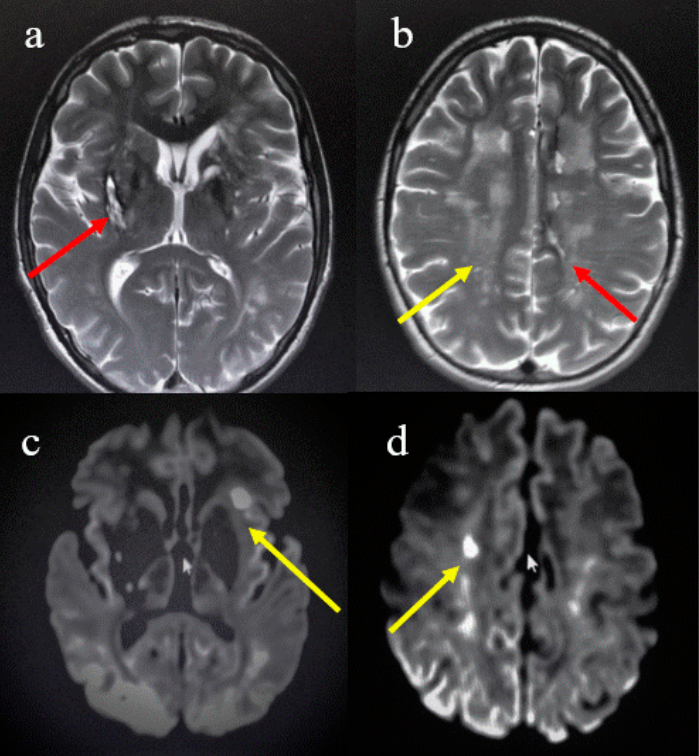
Figure 1. First brain MRI (3 months later the onset of hemiparesis). In the image “ a ”, T2 weighted sequence shows an hypertense area with hypointense ring compatible with the chronic phase evolution of the previous hemorrhage in the right basal ganglia (red arrow). In the image “ b ”, T2 weighted sequence shows white matter alterations with leukoencephalopathy (yellow arrow) and hypointense signal in some left cerebral sulci at brain convexity compatible with hemosiderin foci (red arrow); images “ c ” and “ d ” report DWI sequences with restricted diffusion lacunar areas compatible with subacute ischemic lesions in the left frontal-orbital subcortical area (yellow arrow in the image “ c ”) and in the correspondence of the corona radiate (yellow arrow in the image “ d ”). One year later, an MRI follow-up scan was performed showing a new little ischemic lesion in the right periventricular area (Figure 2a), suggesting a subacute ischemic phase. The leukoencephalopathy was found as mildly more extensive (Figure 2b,c). The Suscepti- bility weighted imaging (SWI) sequence also highlighted the presence of some microbleeds and left superficial hemosiderosis in the cerebral sulci at the brain convexity (Figure 2d). The autoimmune assessment showed a persistent mild elevated LAC confirmed by dRVV ratio (value